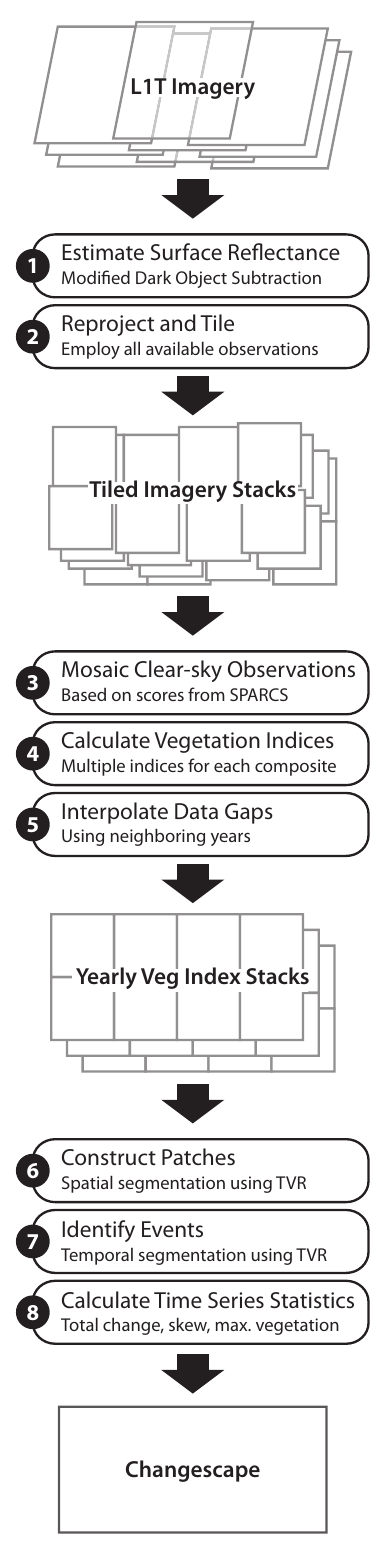
Figure 2. Schematic of VeRDET pro- cessing steps to identify years and locations of forest change. TVR: total variation